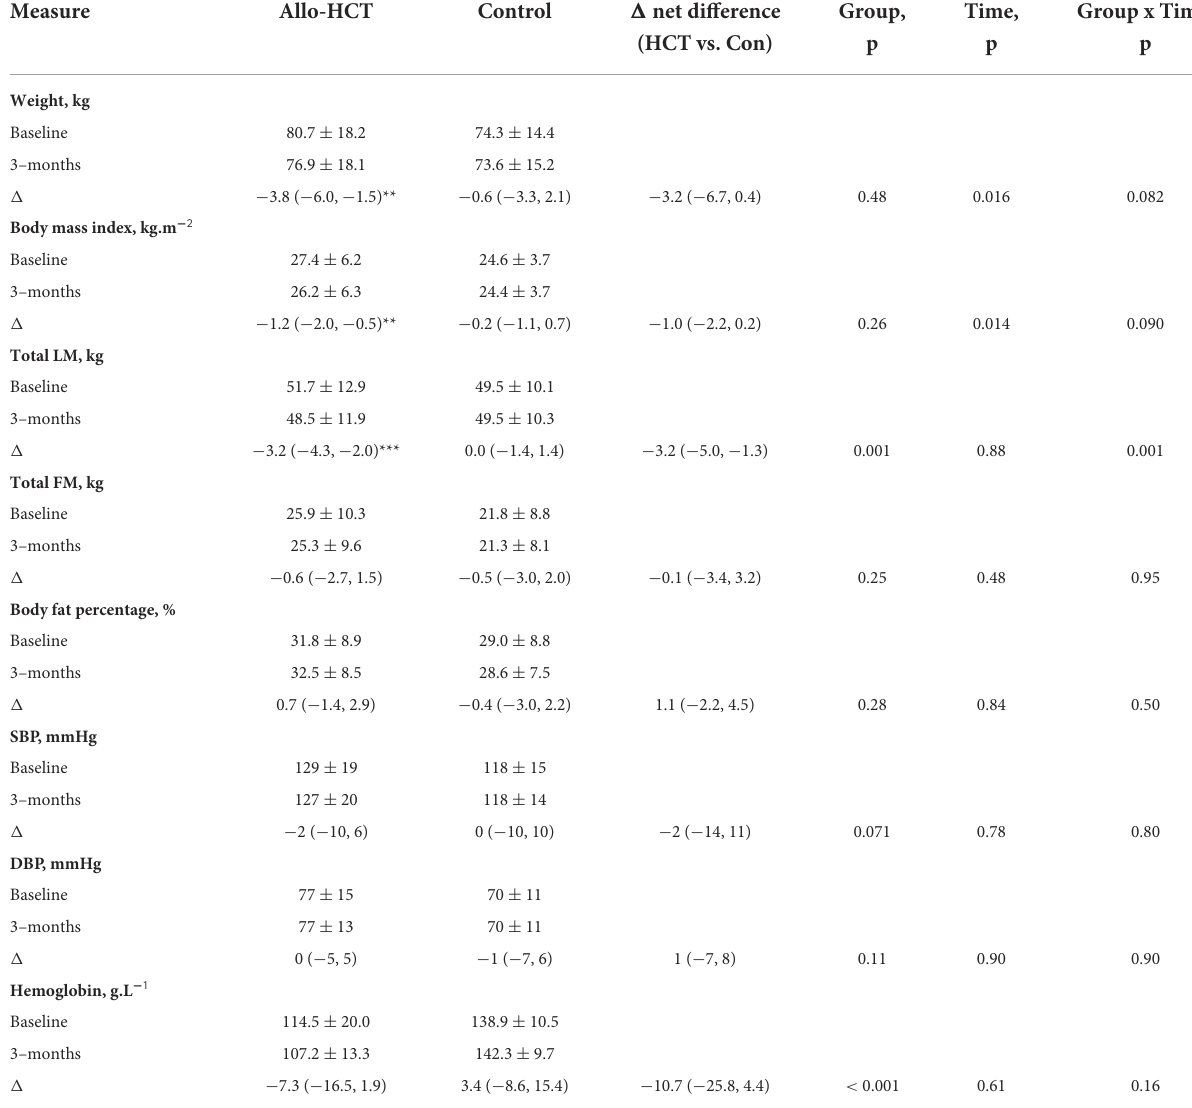
Allbaselineand3–monthvaluesareunadjustedmeans ± SDs;allwithin-groupchangesareunadjustedmean(95%CI)andexpressedasabsolutechangefrombaseline.Meannetdifferences were calculated by subtracting the within–group changes from baseline in the control group from the within–group change from baseline in the allo–HCT group after 3 months. ** p < 0.01,*** p <